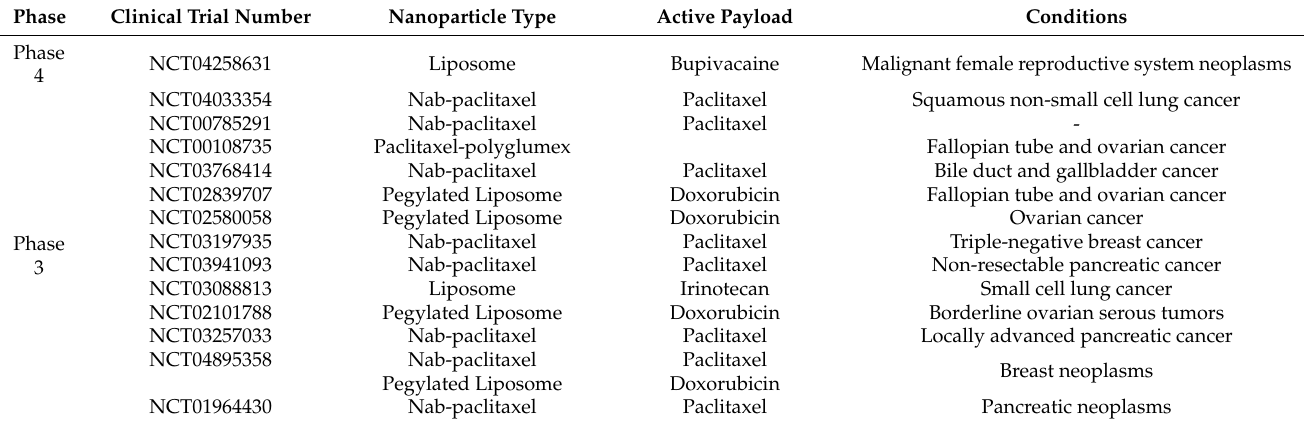
Table 1. Active advanced stage clinical trials of nanoparticle cancer drugs in the United